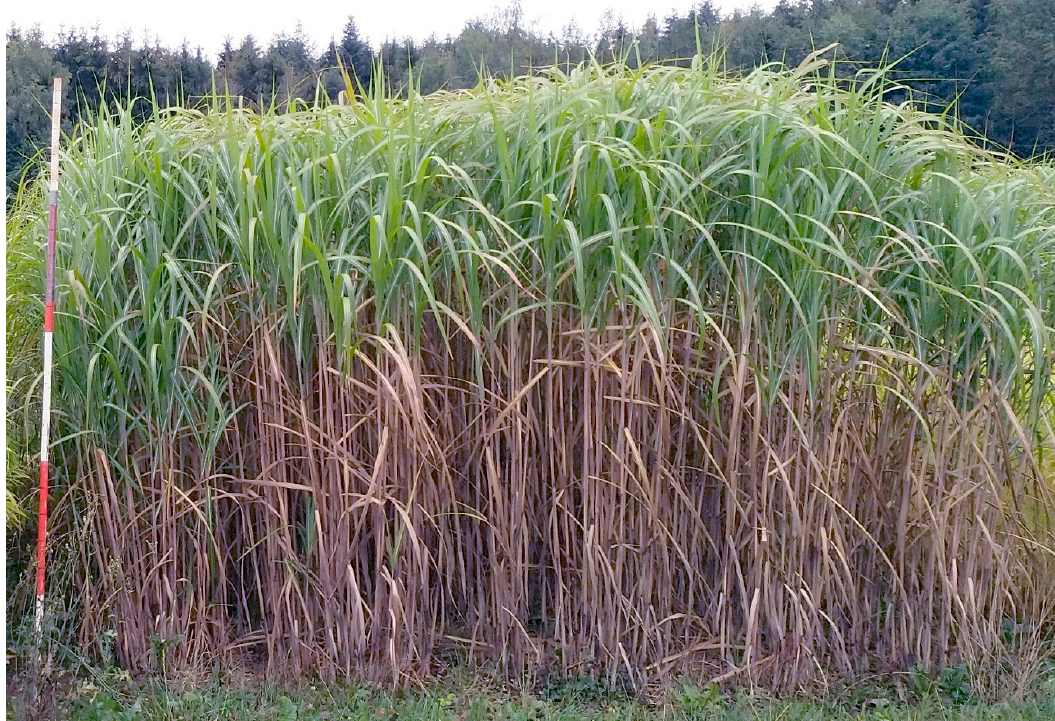
Figure 5. Four-year old miscanthus ( Miscanthus × giganteus Greef et Deuter) grown on a shallow stony soil in southwest